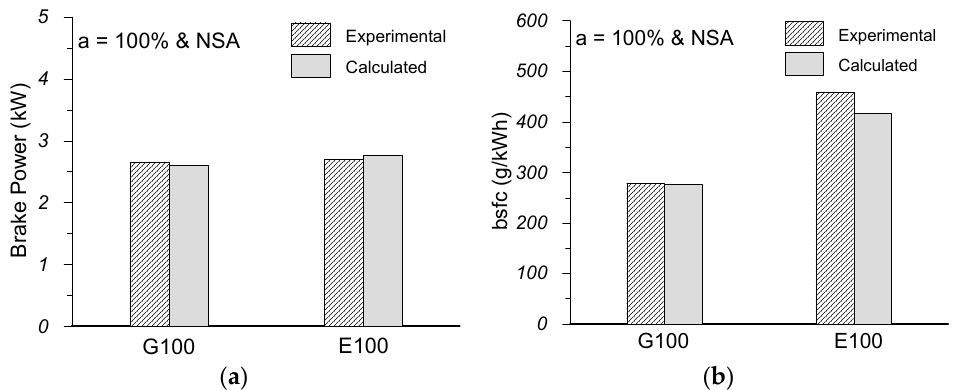
Figure 2. Comparison between calculated and experimental values of brake power output ( a ); and brake specific fuel consumption ( b ); of the “DatsuL200” engine running at 100% of full engine load and 2400 rpm engine speed with normal spark timing, under G100 or under E100 fuel operating modes.